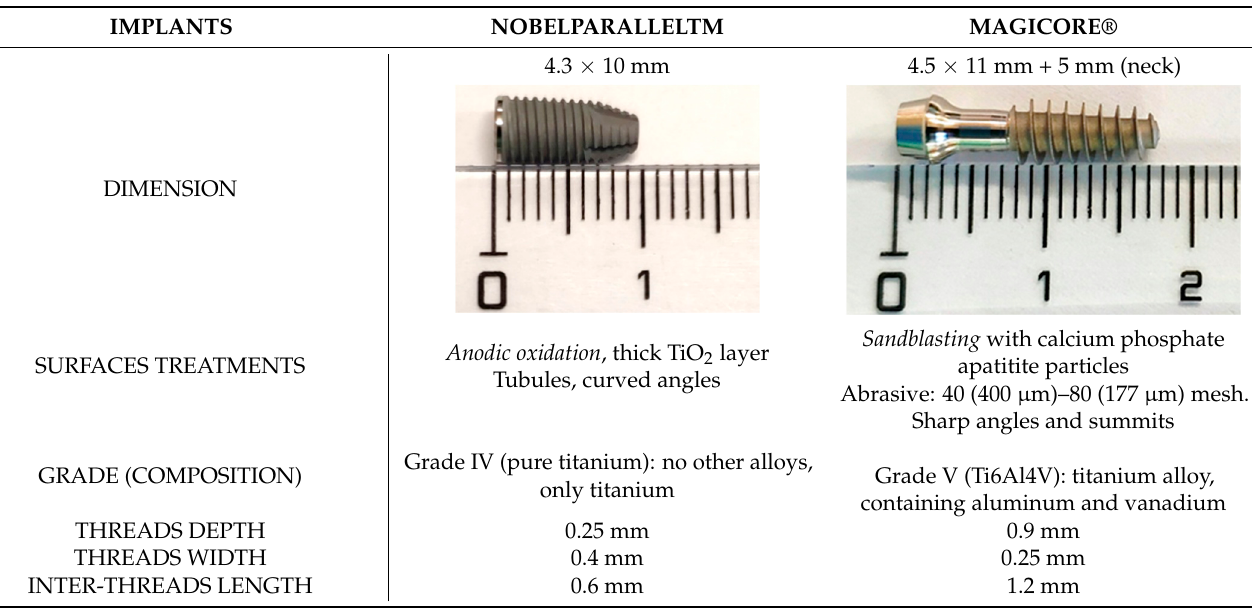
Table 1. Tested implants, their surface treatment, and their composition according to the corresponding titanium grade. Thread dimensions were measured by optical digital microscopy.